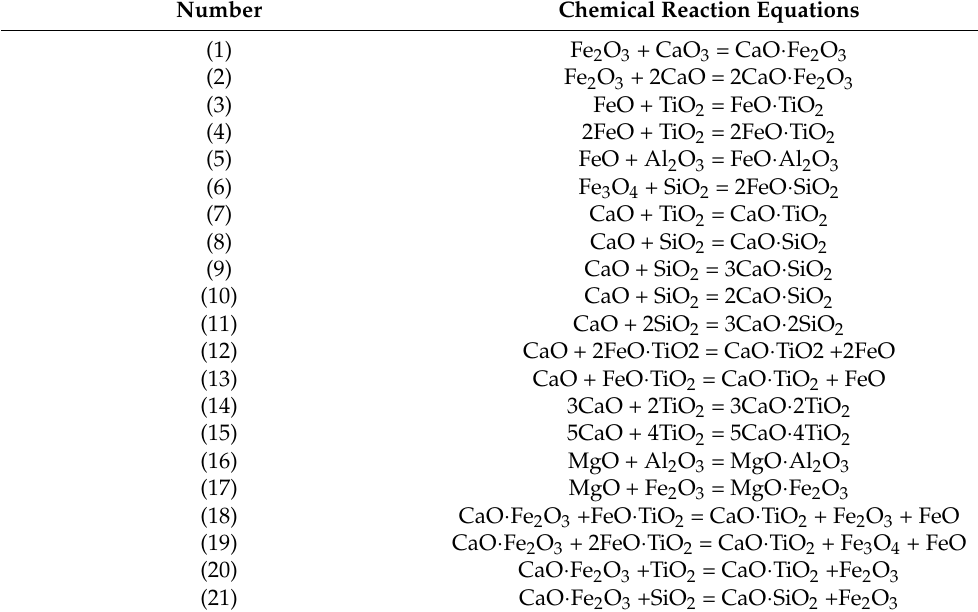
Table 4. Main chemical